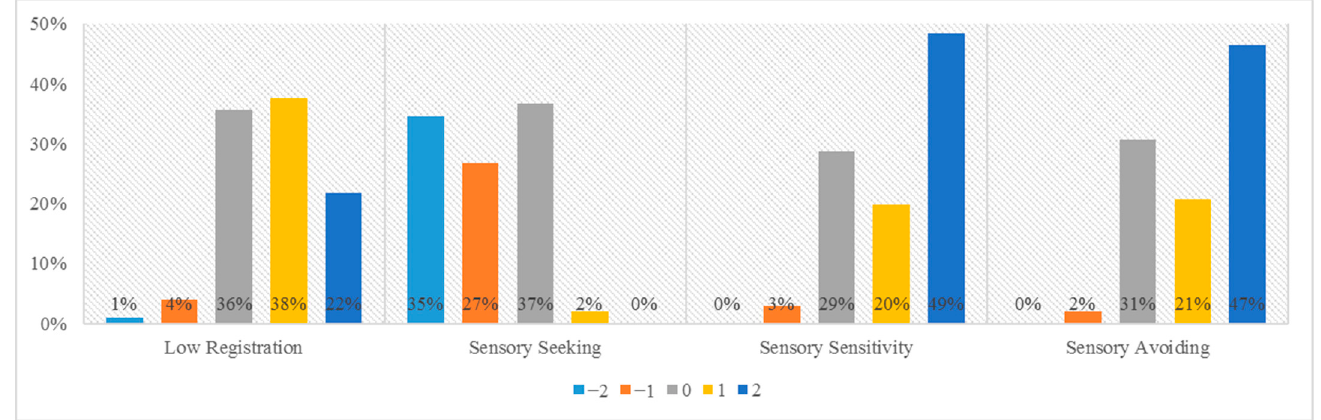
Figure 1. Percentage of AASP quadrant scores per distance from the AASP norm group. The labels − 2 to 2 are used as equivalent for the AASP’s descriptions for norm group comparison, ranging from ‘much less than most people’ to ‘much more than most people’.